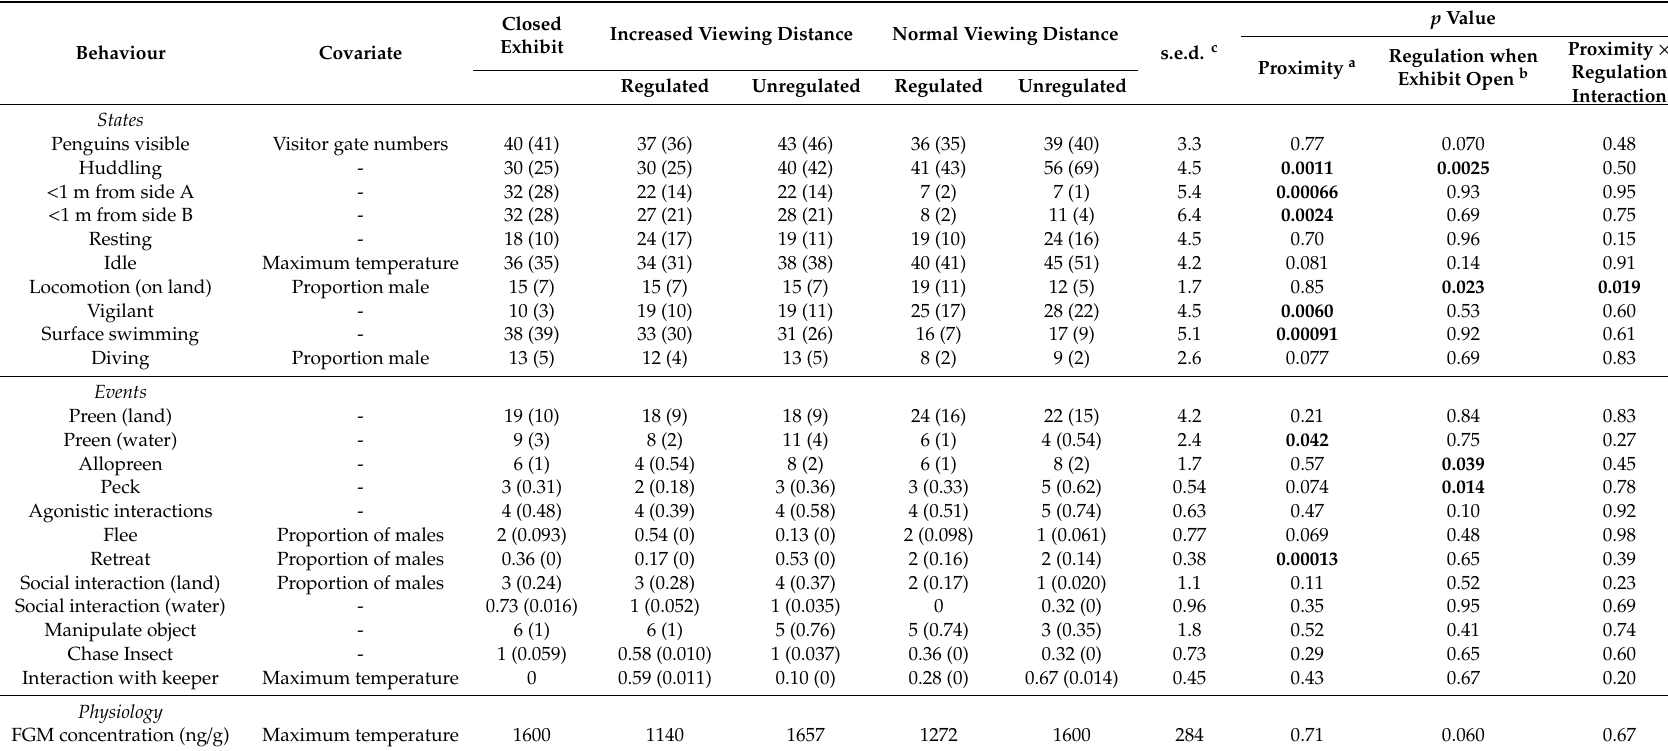
Table 4. E ff ect of treatment on the mean proportion of visible penguins (%) performing each behaviour (state and event) per 2-day period and stress physiology. Results are the average proportion of visible penguins performing each behavior. Data were angularly transformed, except for FGM concentrations. Back-transformed means are presented in